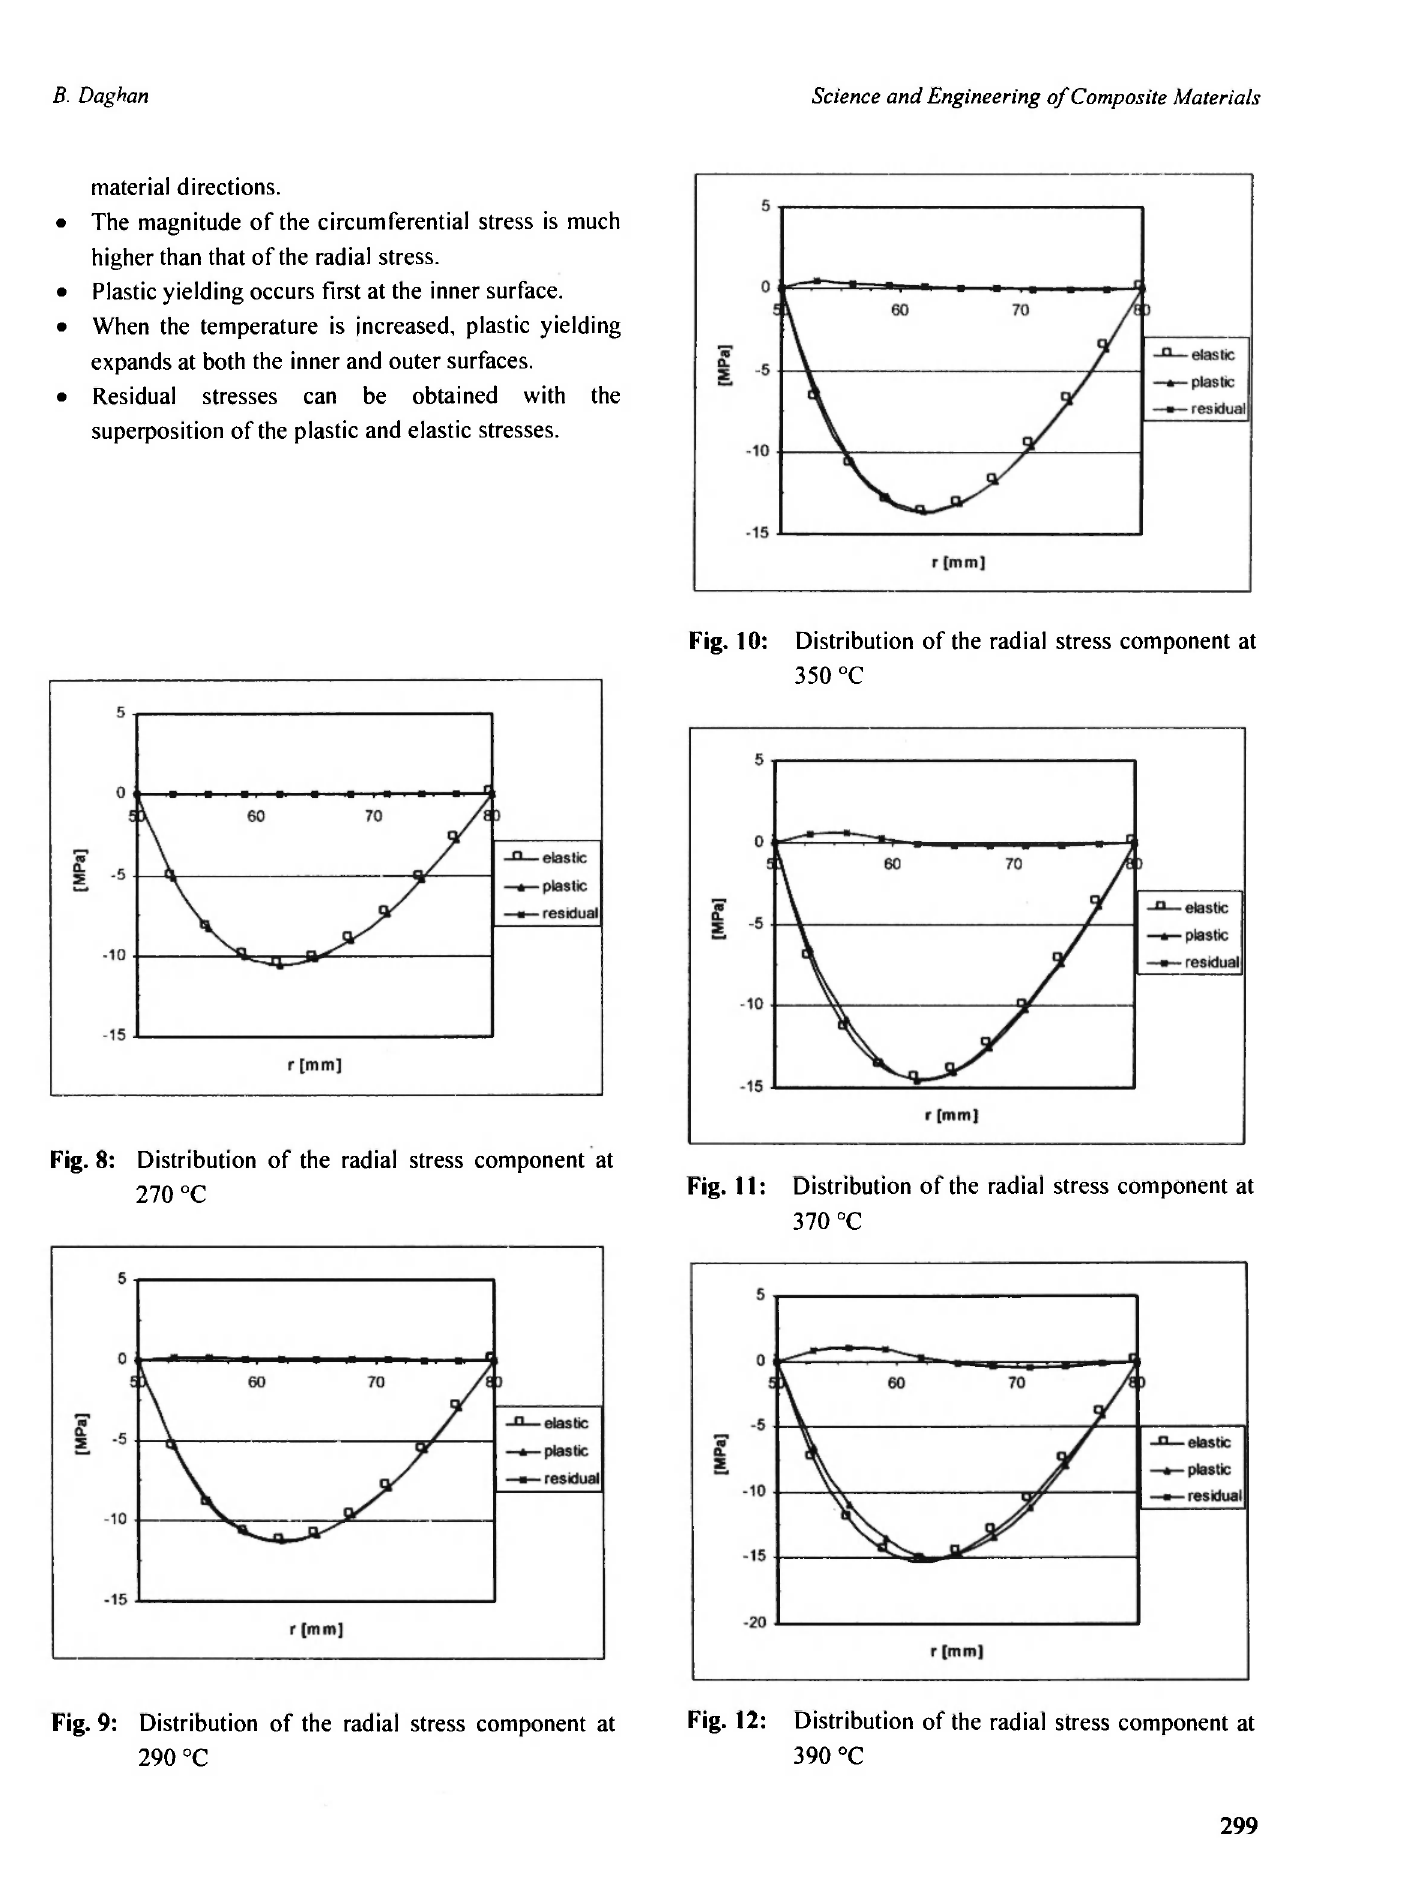
Fig. 12: Distribution of the radial stress component at 390 °C